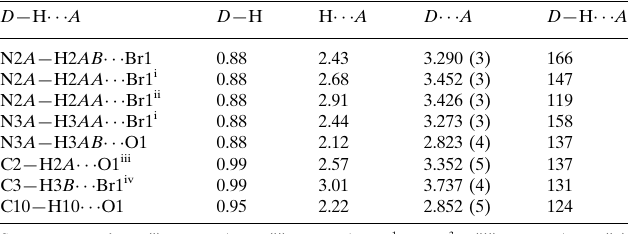
Hydrogen-bond geometry (A˚ , (cid:3)